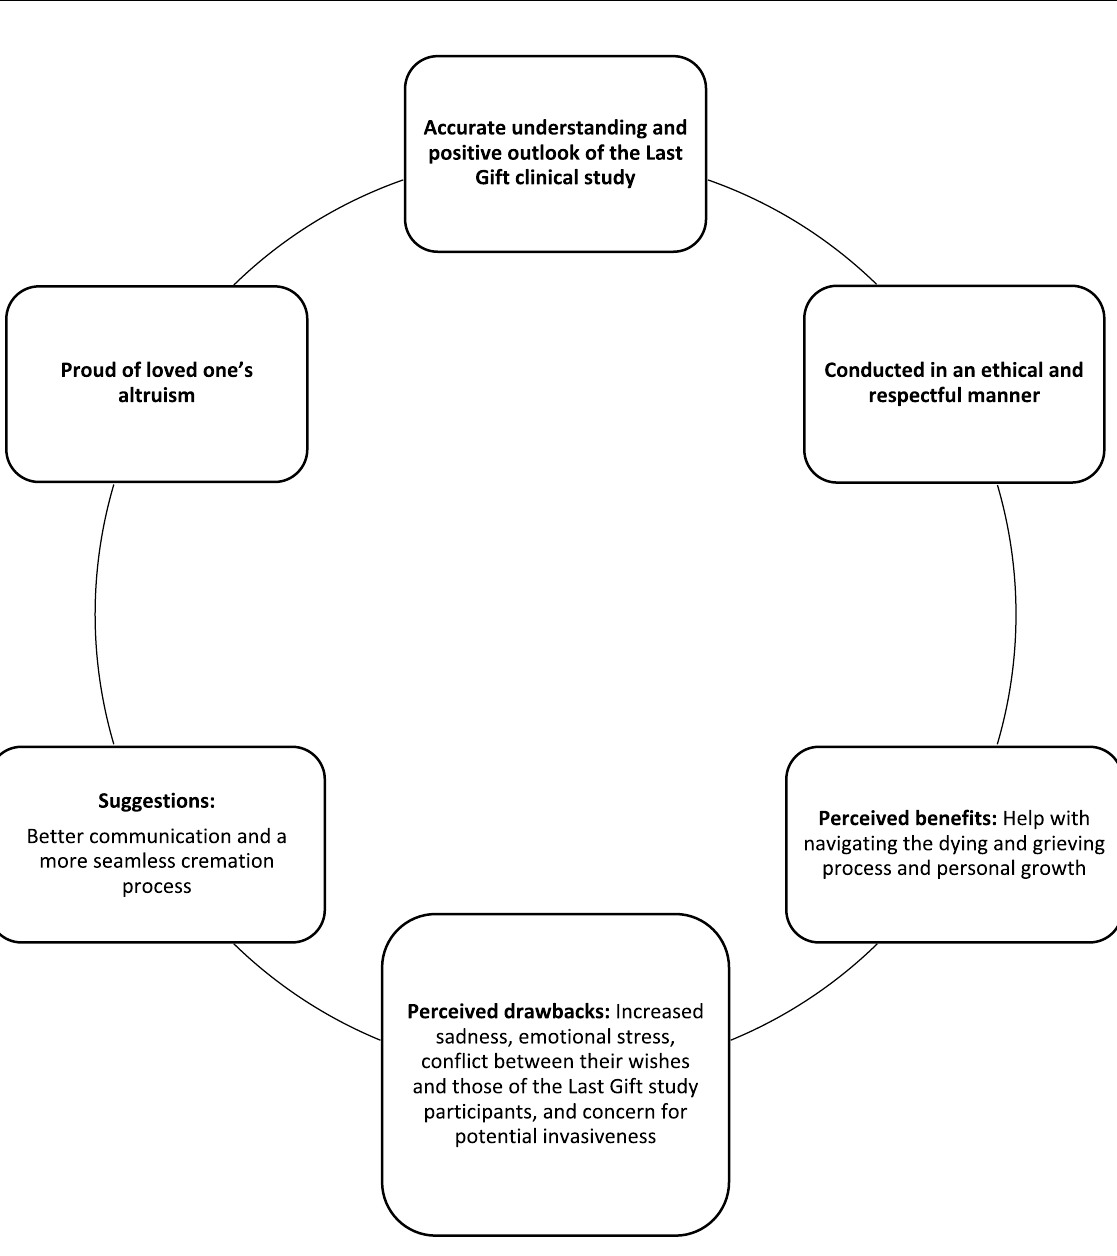
Fig 1. Summary of the six emerging themes from discussions with